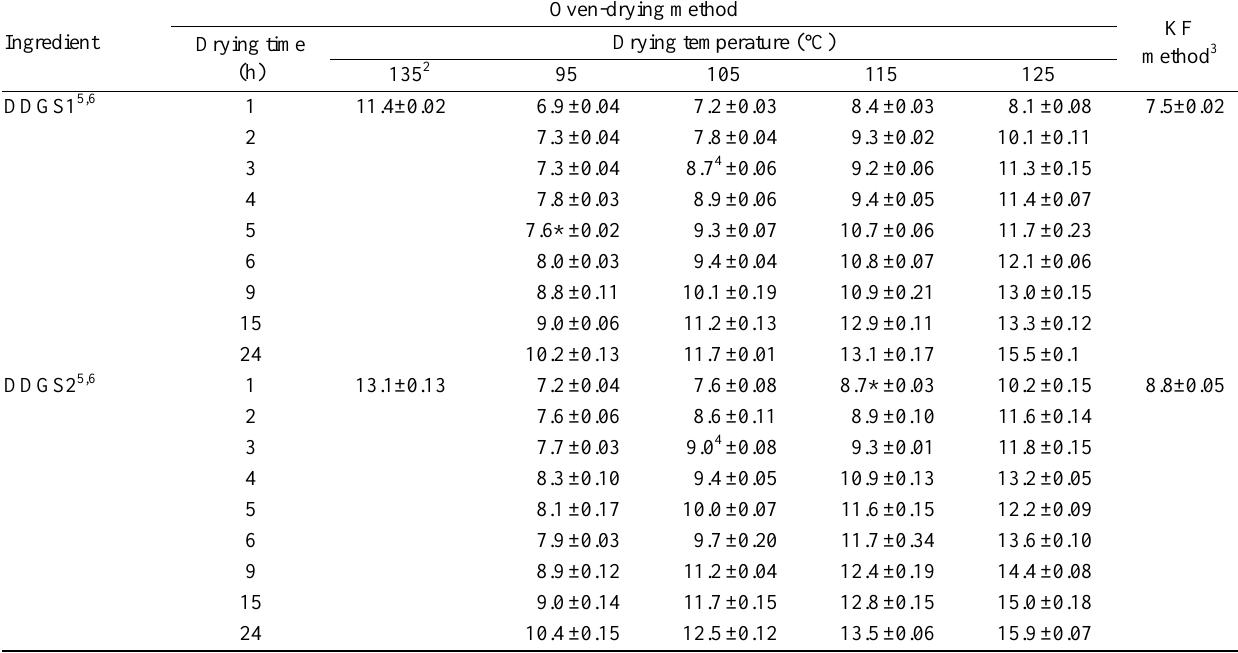
Table 4. Moisture concentrations (%) in DDGS1, and DDGS2 determined by various oven methods and the Karl Fischer (KF) method (Exp. 2) 1